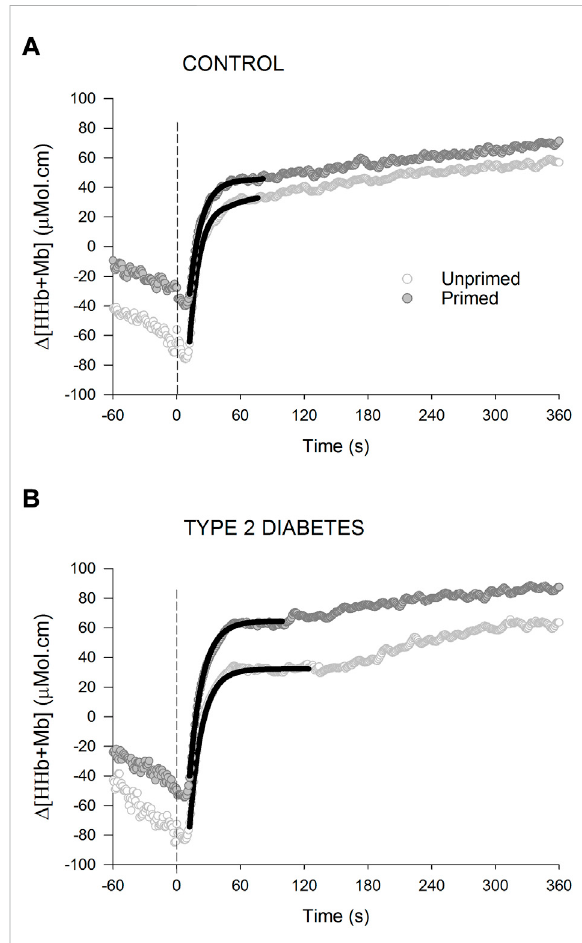
FIGURE 4 Changes in deoxygenated hemoglobin and myoglobin concentration [ Δ (HHb + Mb)] for a representative healthy control (A) and an individual with type 2 diabetes (B) during high-intensity cycling transitions without priming exercise (open circles) and with priming exercise (solid circles). The vertical line illustrates theabrupttransitiontothehigher workrate.Thecontinuousblack lines of best fi t illustrate the primary phase of the Δ (HHb + Mb) response. Note the time constant of the primary phase of the Δ [HHb + Mb] response is not affected by prior priming exercise in any of the 2